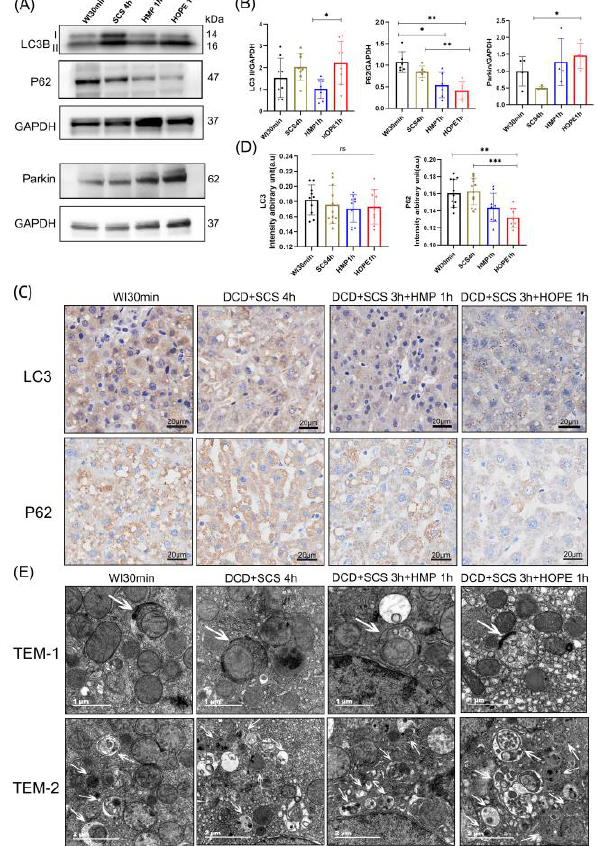
Figure 5. HOPE promoted mitophagy flux in DCD liver. ( A ) Western blot shows the mitophagy related protein levels; ( B ) the quantitative analysis of the relative intensity of LC3-II, P62, and Parkin normalized to the GAPDH loading control; ( C ) IHC staining of LC3 and P62 was performed on the paraffin-embedded section of rat liver tissues. Scale bar: 20 µ m; ( D ) IHC-stained LC3 and P62 were quantified using Image J. ( E ) Electron micrographs of live tissue in four groups. White arrowheads in TEM-1: mitophagy vacuoles. White arrowheads in TEM-2: autophagy vacuoles. ( n = 3 independent experiments for ( A , C , E )). Mean ± SD, N.S., p > 0.05, * p < 0.05, ** p < 0.01, *** p < 0.001.